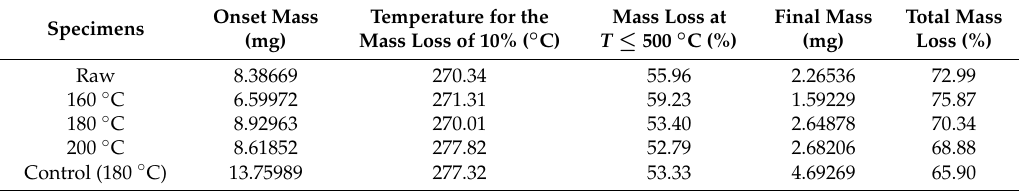
Table 3. Thermal properties of wheat straw and fiberboards produced at different temperatures.